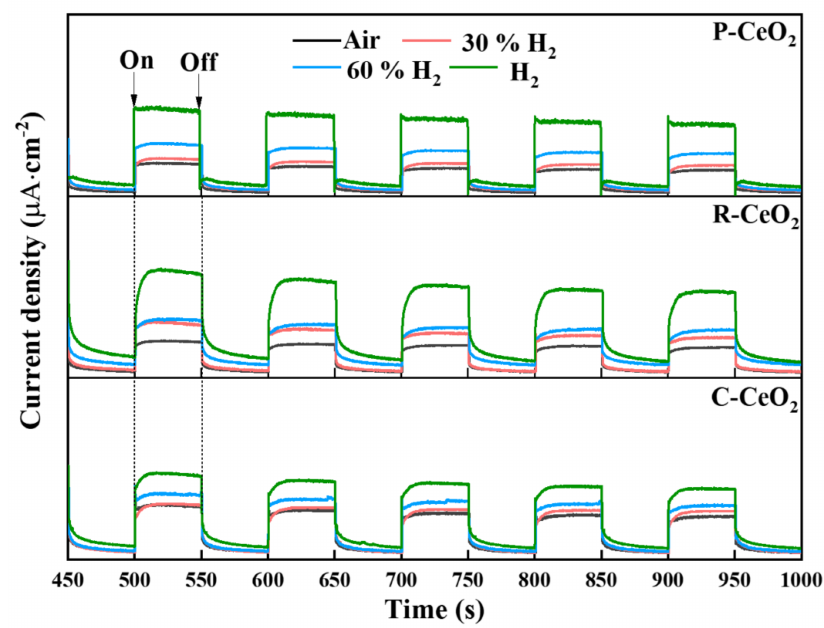
Figure 9. The transient photocurrent curves of P-CeO 2 , C-CeO 2 and R-CeO 2 calcining in different concentration of H 2